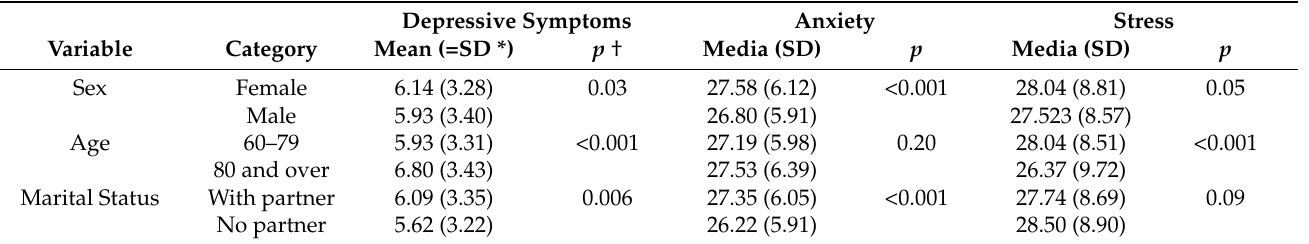
Table 3. Comparison of means of depressive symptoms, anxiety, and stress according to sociodemo- graphic variables of the elderly during the COVID-19 pandemic. Peru,